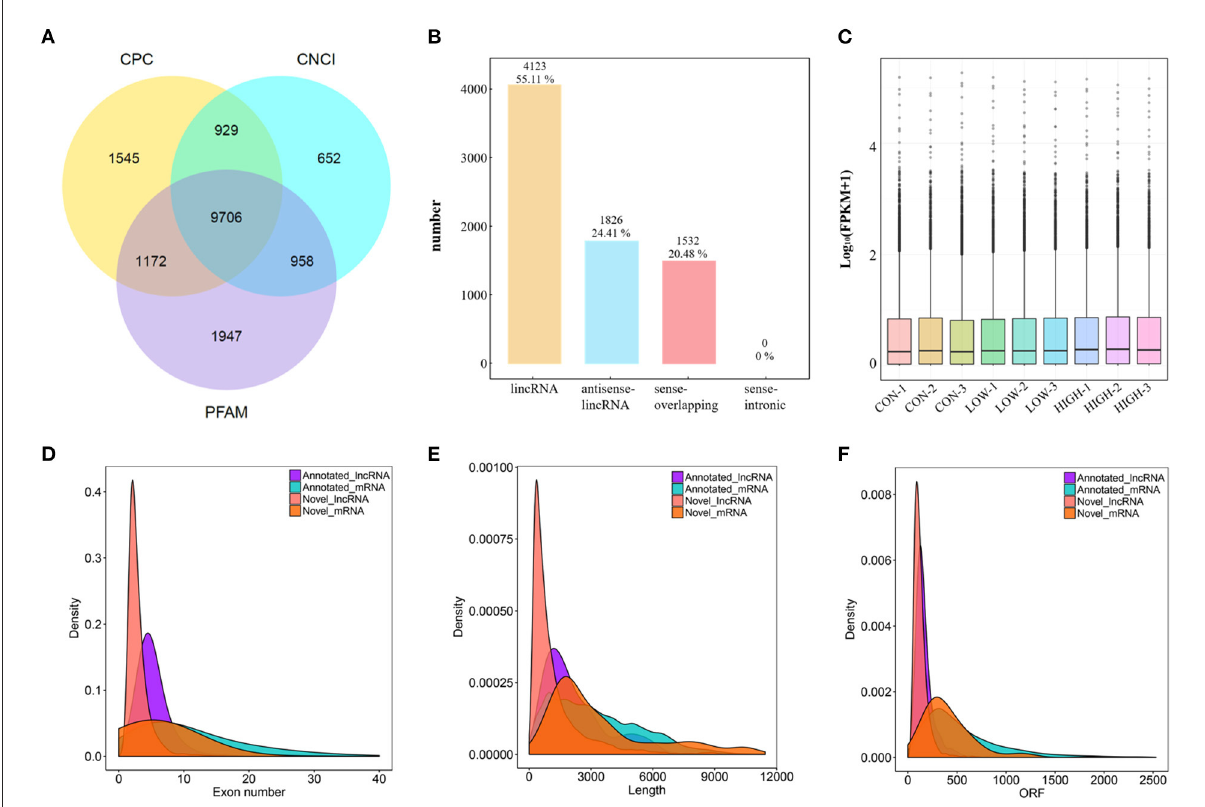
FIGURE3 Characterization of lncRNA and mRNA in POGCs. (A) Coding potential analysis via CNCI (Coding-Non-Coding Index), CPC (Coding Potential Calculator), PFAM (Protein Families database). Those sequences simultaneously shared by the above three tools were selected as candidate lncRNAs. (B) The classification of identified lncRNAs. (C) Boxplot showing the expression features of lncRNA in POGCs. FPKM, fragments per kilobase million. (D–F) Density distribution diagram showing the expression features of exon number (D) , length (E) , and opening reading frame (ORF) (F) of annotated lncRNAs, novel lncRNAs, and mRNAs in